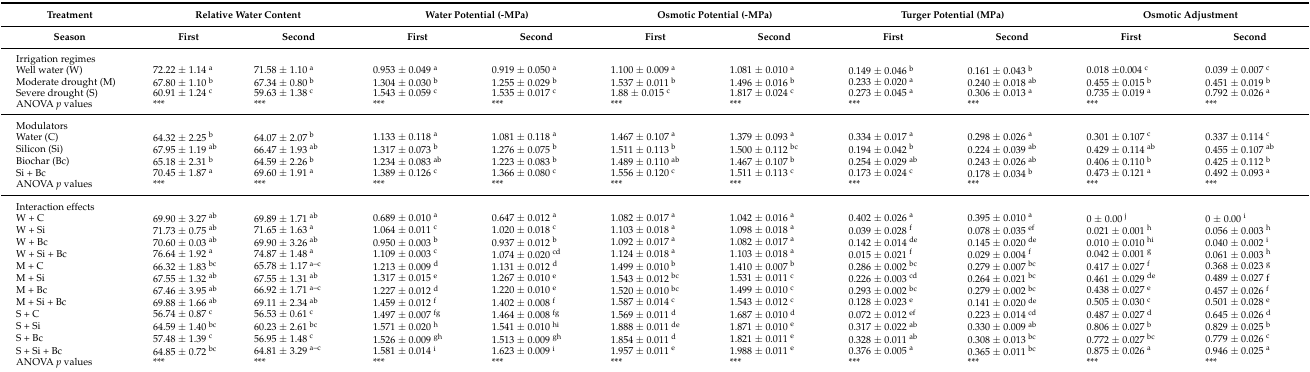
Table 5. Effect of irrigation regimes, silicon, biochar and their interaction on water status of borage plants throughout two experimental years.